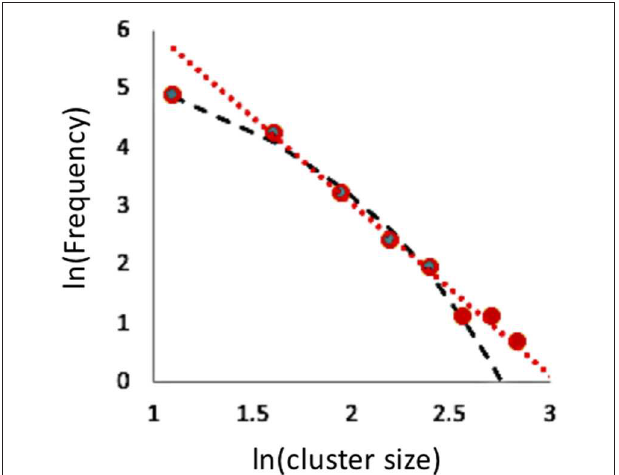
FIGURE 2 | Cluster size distribution for spatial patterns for the last iteration of the standard rule 126 model with no stochasticity and random ( µ allocation of starting positions on a one-dimensional lattice of size 2000, after 200 time steps. Dashed (black) curve is an exponential fit to the lower six points ( R 2 0.99) and dotted (red) line a power function fit to the higher seven = points ( R 2 0.99). Bin sizes 1–3; 3–5; = =